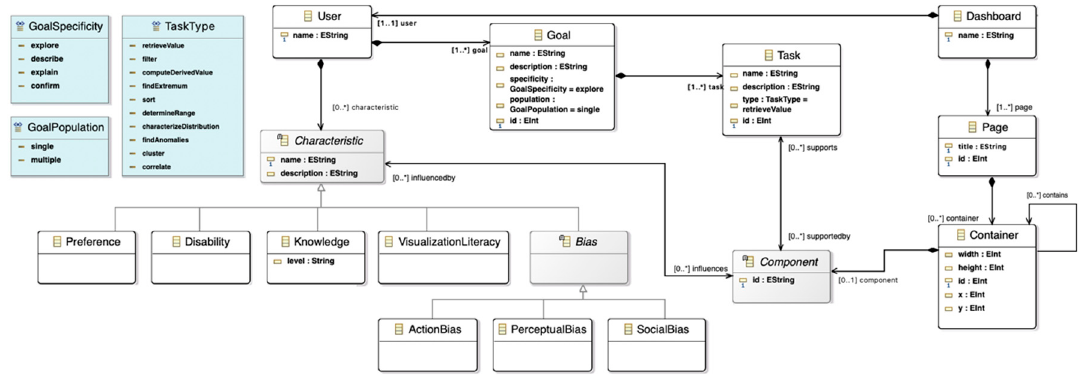
Sensors 2020 , 20 , x FOR PEER REVIEW Figure 4. User and layout section of the dashboard meta-model. Figure 4. User and layout section of the dashboard meta-model.